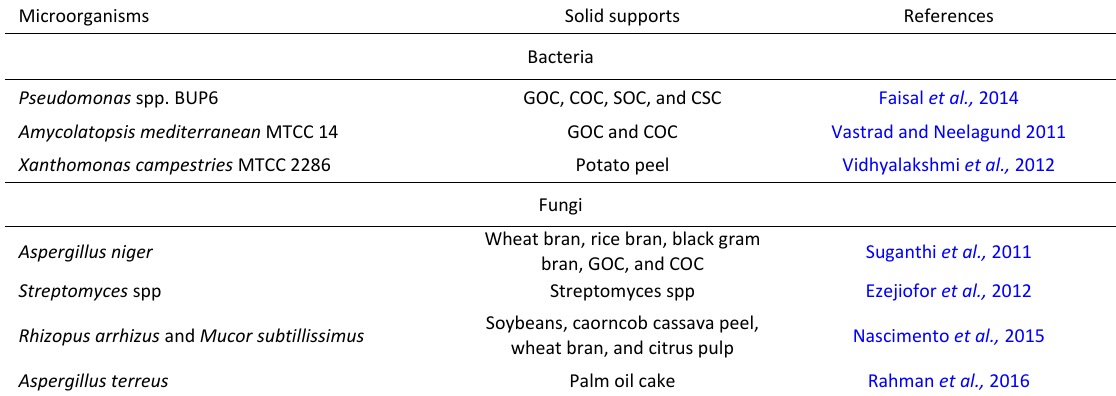
Table 5: List of microorganisms used in solid fermentation process Microorganisms Solid supports